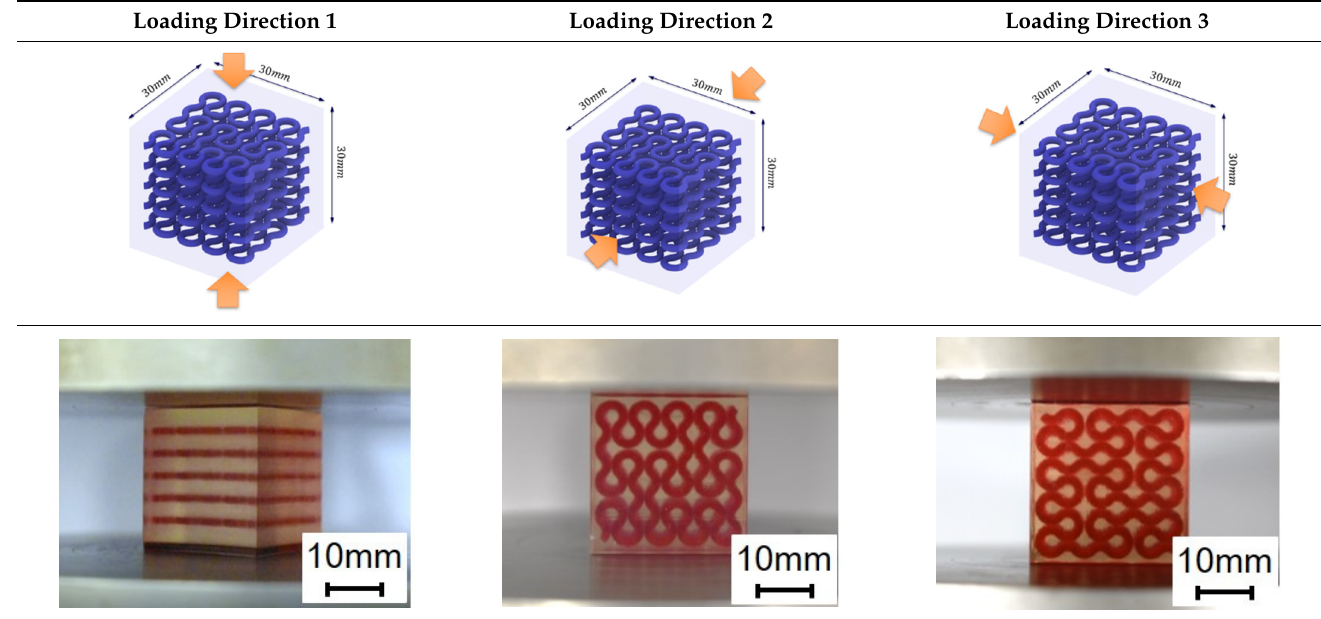
Table 1. Schematic diagrams and experimental pictures showing three different compressive loading directions (taking the case 2 design as a schematic example).